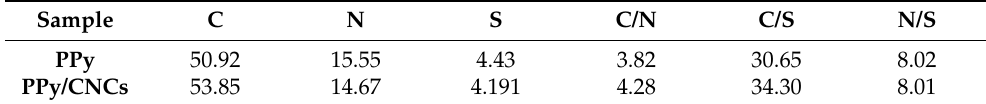
Table 1. Elemental analysis (wt%, molar ratio) of PPy and